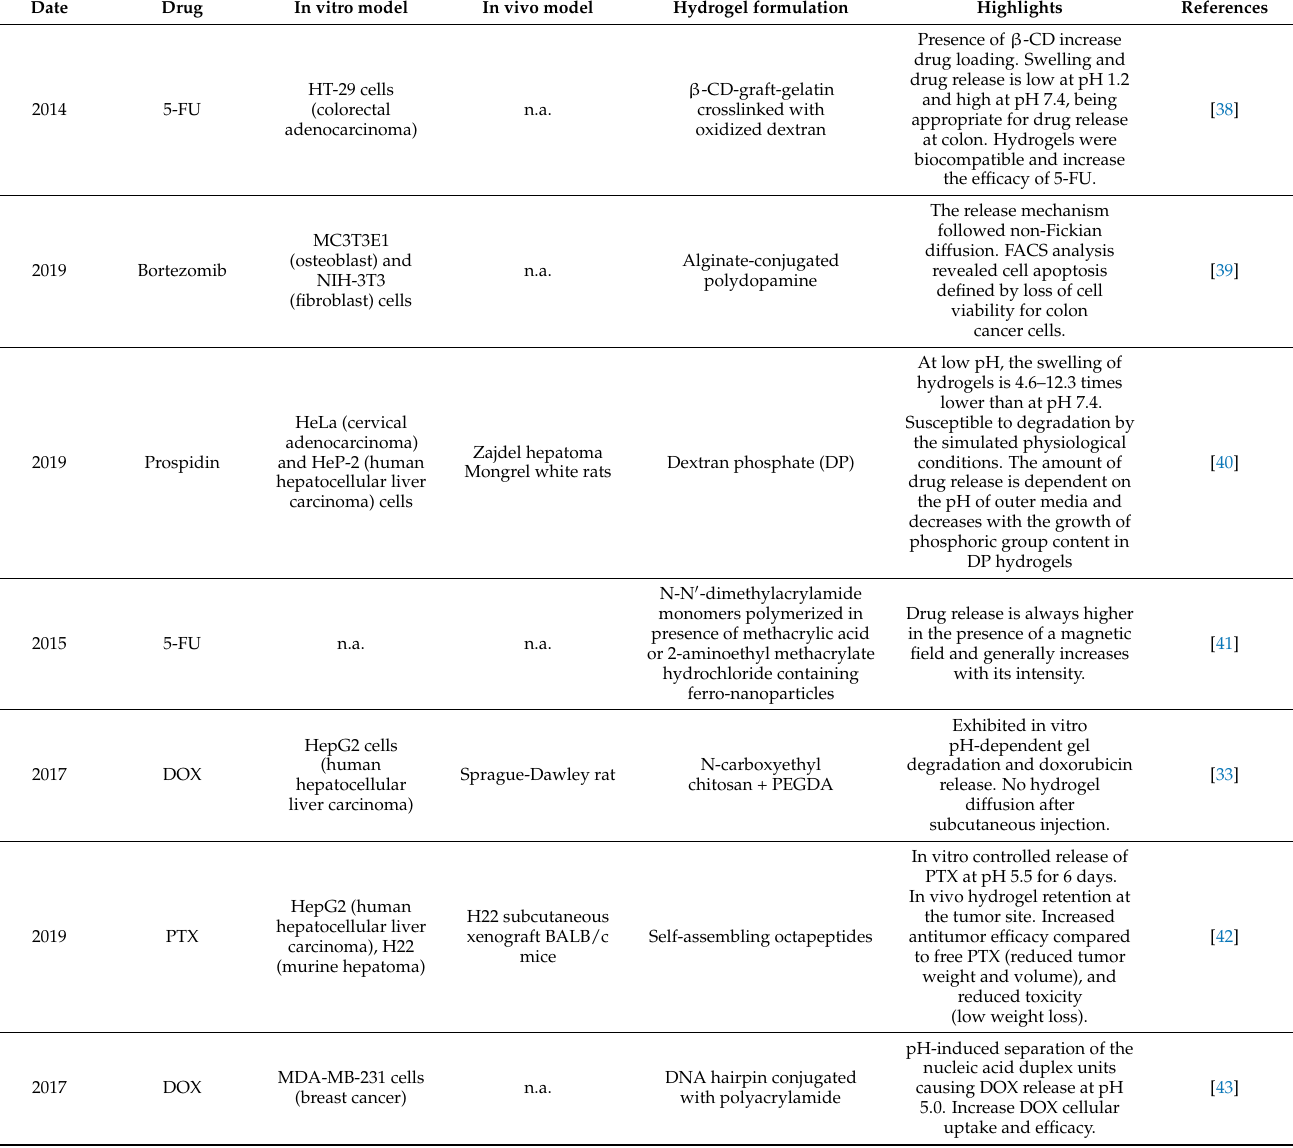
Table 2. Examples of pH-sensitive hydrogels for cancer therapy. n.a.—not applicable; β -CD— β -cyclodextrin; 5-FU—5- fluorouracil; DOX—doxorubicin; FACS—fluorescence-activated cell sorting;